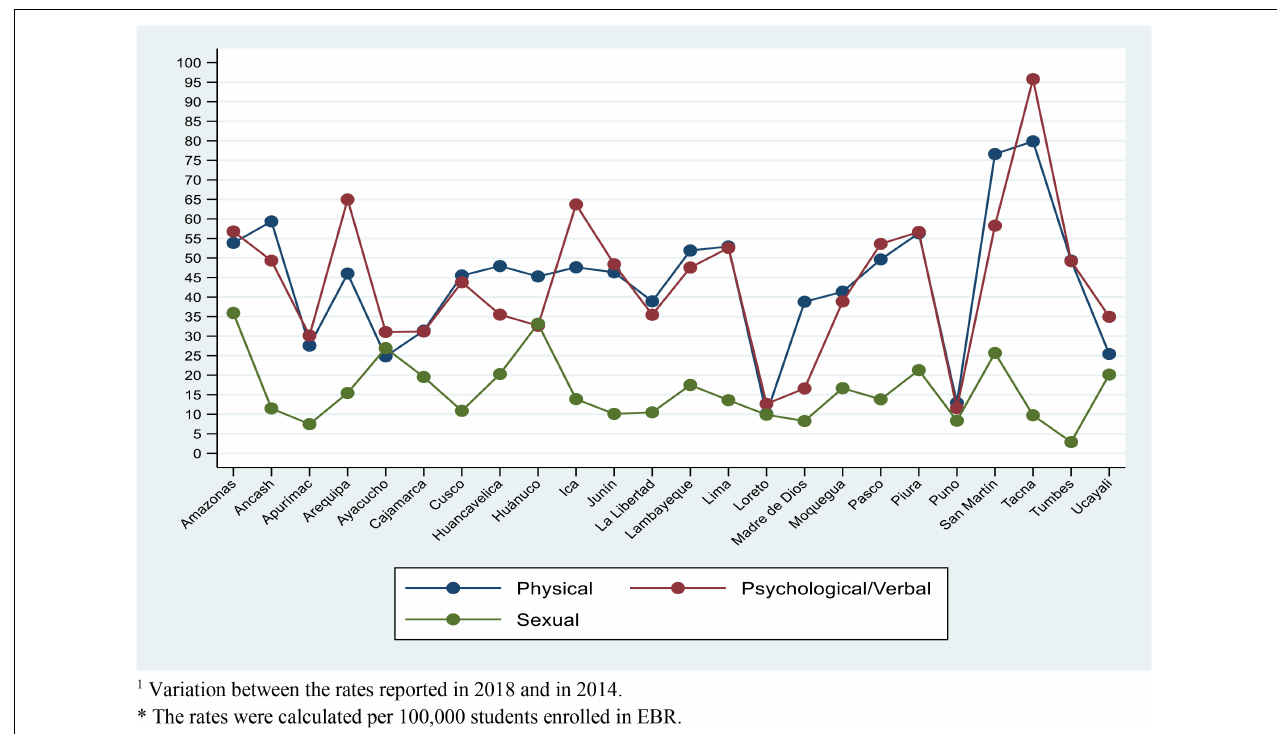
FIGURE 1 | Change in rates reported by type of violence in 2018 compared to 2014, according to departments in Peru. Variation between the rates reported in 2018 and in 2014. The rates were calculated per 100,000 students enrolled in